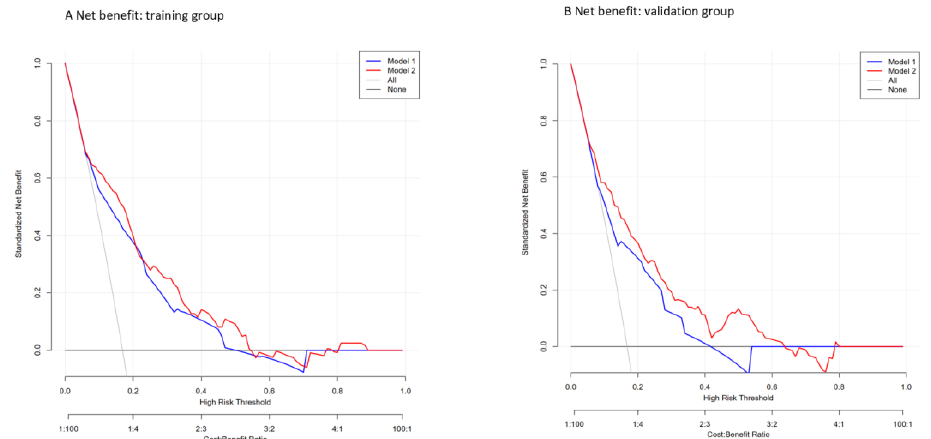
Figure 4. DCA of the clinicopathologic and MRS-based nomogram for predicting LVSI in the training cohort and validation cohort. Solid blue line = net benefit when all EC patients are considered as not having the outcome (negative LVSI); red dashed line = net benefit when all EC patients are considered as having the outcome (positive LVSI).